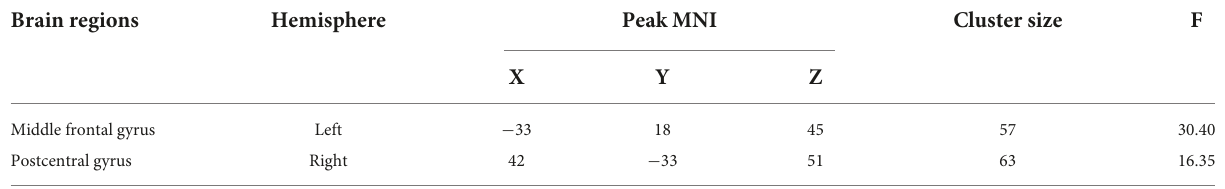
TABLE 2 Group differences in amplitude of low-frequency fluctuations in MDD with childhood trauma, MDD without childhood trauma and HC. Brain